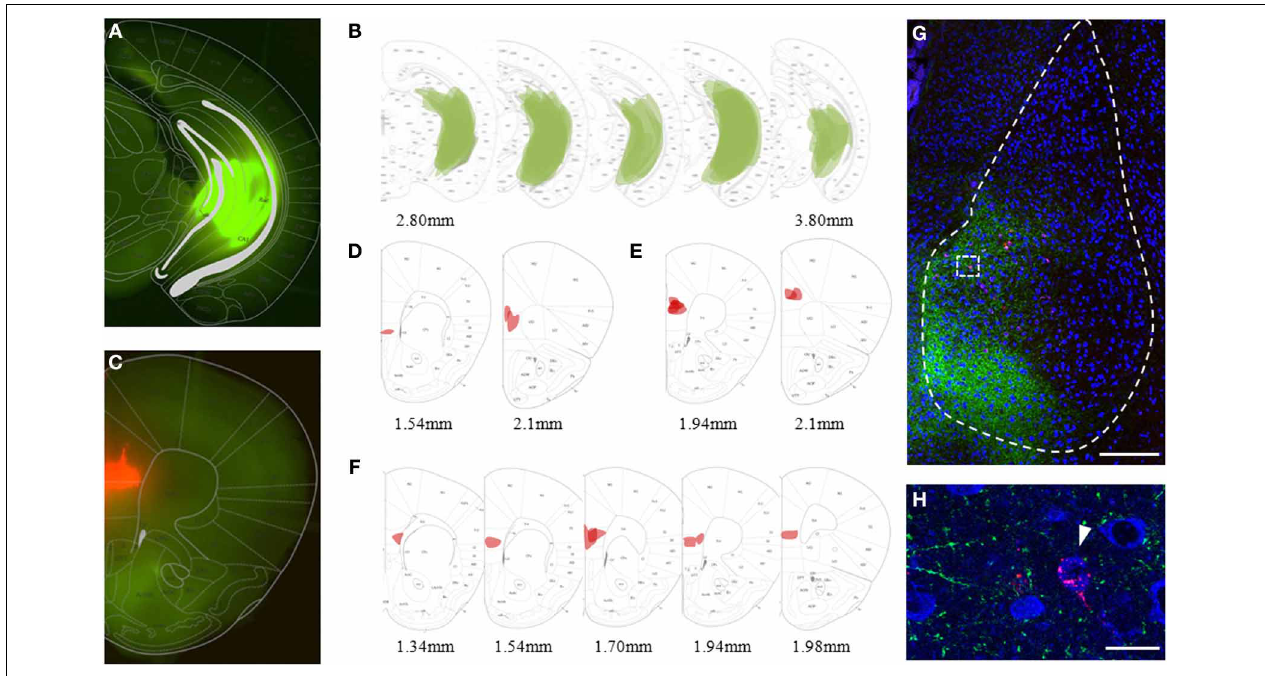
FIGURE 2 | Viral and bead injection sites for studying hippocampal inputs to BLA. (A) Stereoscopic picture of a representative brain slice of an animal injected in the ventral hippocampus (vHC) with rAAV-ChR2(H134R)-eYFP (green). (B) Overlay of vHC viral injection sites with the mouse brain atlas for all animals analyzed ( n = 23). (C) Stereoscopic picture of a representative brain slice with retrobead injection site in the mPFC (red) of the same animal. (D–F) Overlay of main retrobead injection